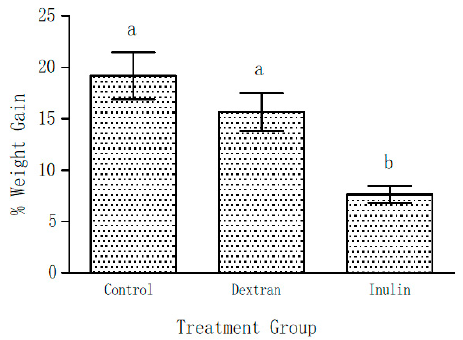
Figure 2. Weight gain shown as percentage increase over the initial (day 0) body weight after 21 days of feeding the mice with and without EPS supplemented feed. Data represent mean ± SEM. ( N = 6 for each group). The bars labelled with the same letter are not significantly different i.e., a p > 0.05; b p < 0.05 compared with the control and dextran-fed groups.